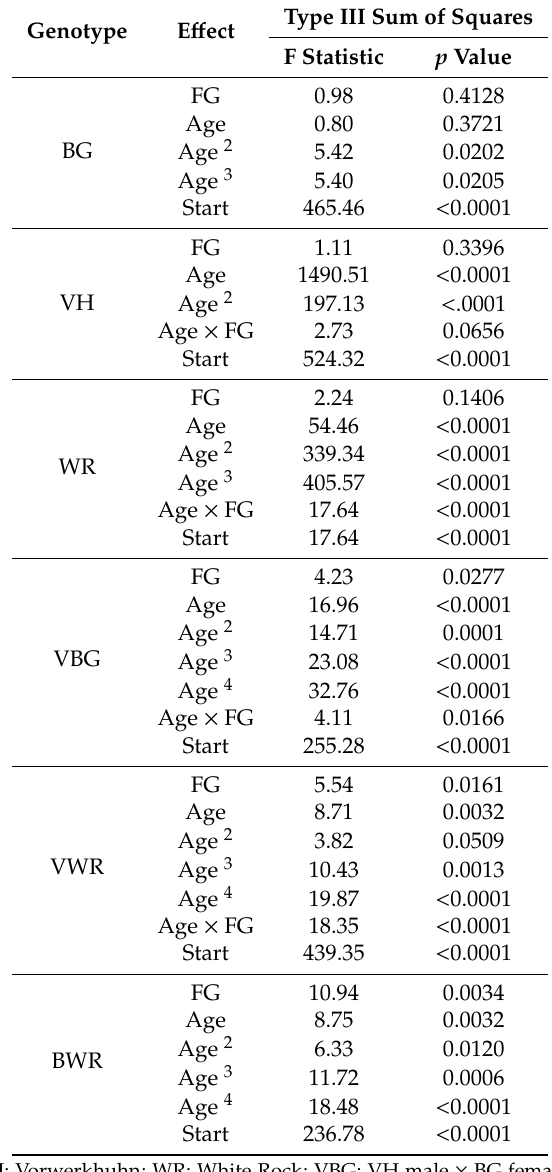
Table 2. Significance of sources of variation in the analysis of weight